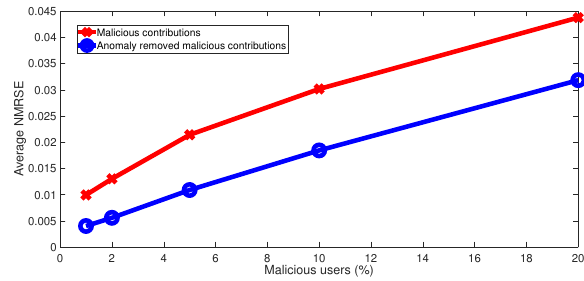
Figure 9: Average NRMSE for malicious contributions vs. anomaly removed malicious